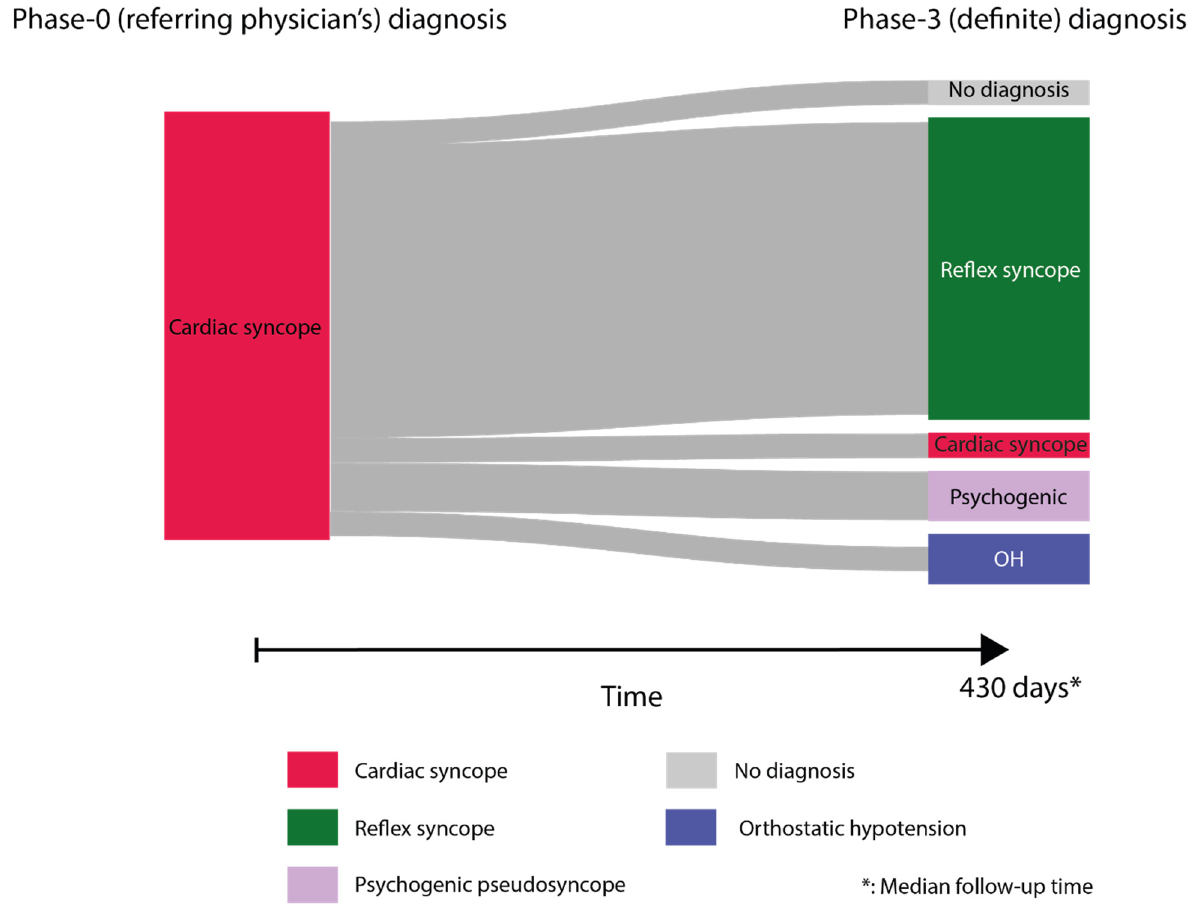
Figure 2. Transition plot (or Sankey diagram) depicting fl ow of patients with referral diagnosis of cardiac syncope (phase 0) to phase 3 diagnosis. Coloured bars indicate diagnoses. Sizes are proportional to the number of patients. Grey lines re fl ect patient fl ow from phase 0 to phase 3 diagnosis. Size re fl ects the number of patients in each line.